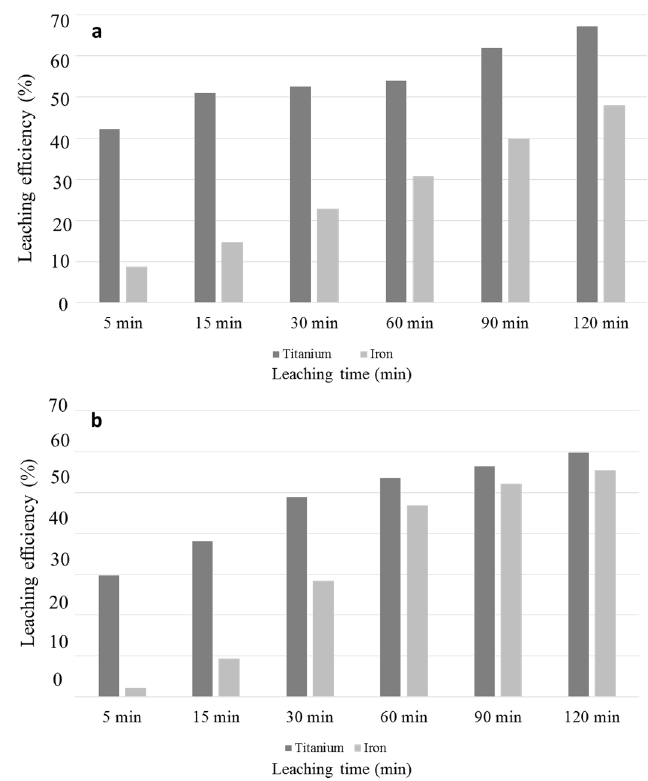
Figure 7. Titanium and iron leaching efficiencies by ( a ) sulfuric acid; ( b ) hydrochloric acid leaching (where 100% Ti and Fe leaching efficiencies corresponds to 0.94 g Ti and 8.47 g Fe in 1 L acid solution) .